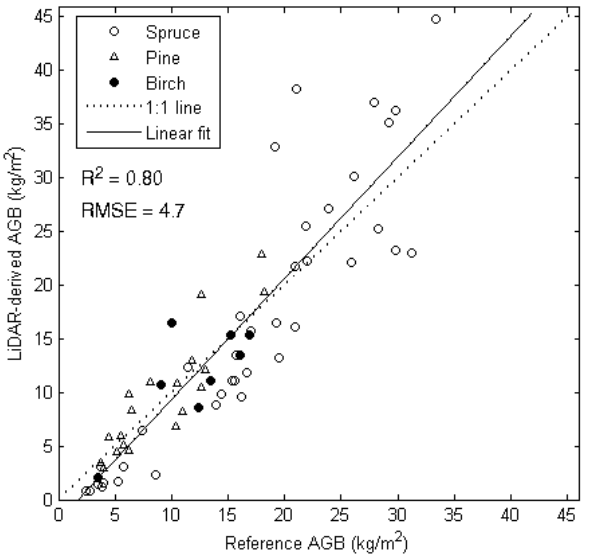
Figure 7. Field-measured vs. predicted AGB using the grid-based approach with 3 m × 3 m cell